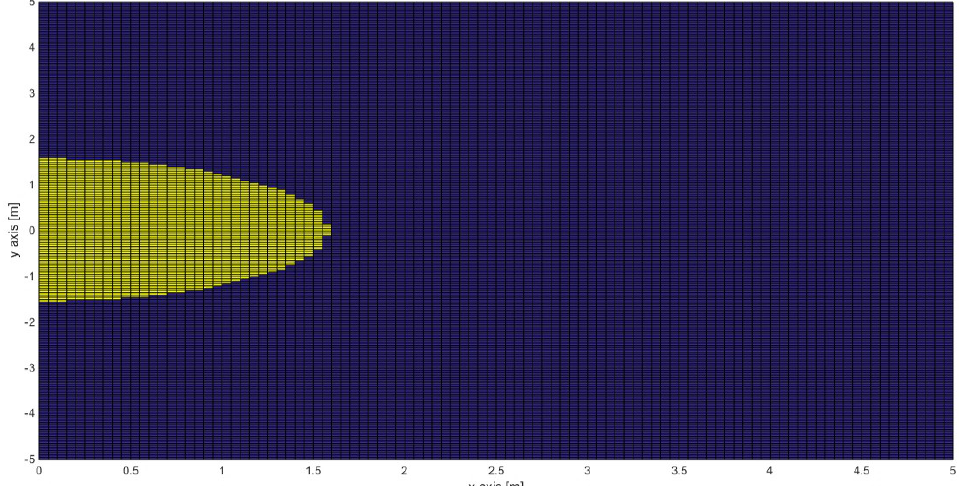
Figure 19. Area of electric field strength, with values higher (yellow) and lower (blue) than the limit of 1.25 V/m for method “C”, of linear current source, for the area of Korakia ( ρ S = ∞ , without dam, L = 1.1815 m, ρ w = 0.25 Ω · m, θ = 248 ◦ , J maintenance_steady = 22 A/m 2